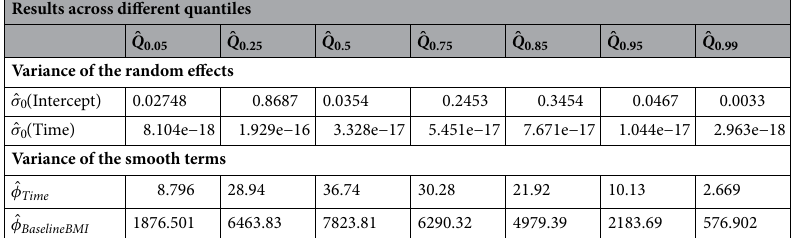
Results across different quantiles